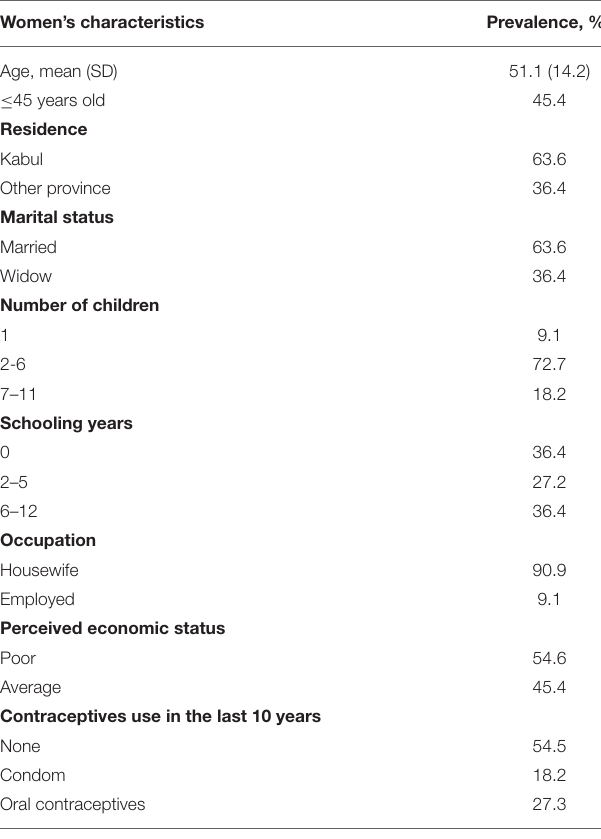
TABLE 1 | Characteristics of participants ( N = 11). TABLE 2 | Outcomes and clinical characteristics of participants ( N = 11).